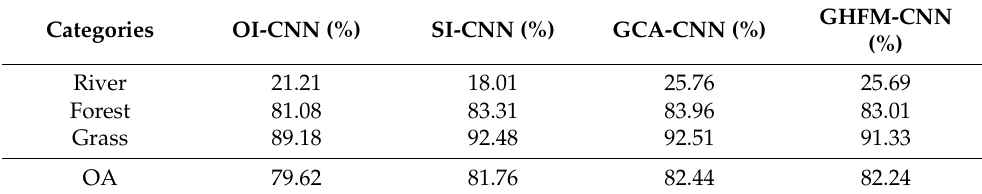
Table 4. Accuracies onTerraSAR-X SAR